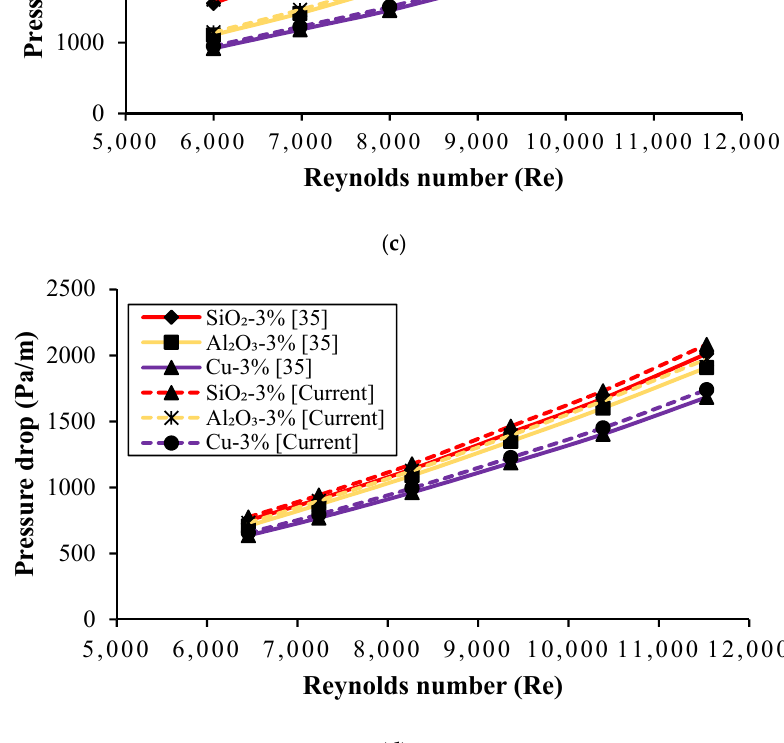
Figure 2. Validation and verification of current pressure drop data; ( a ) Comparison with the equation given by Blasius for DW; ( b ) comparison with GNPs nanofluids for square duct [23]; ( c ) comparison with GNPs nanofluids for circular duct [23]; ( d ) comparison with different nanofluids for circular pipe